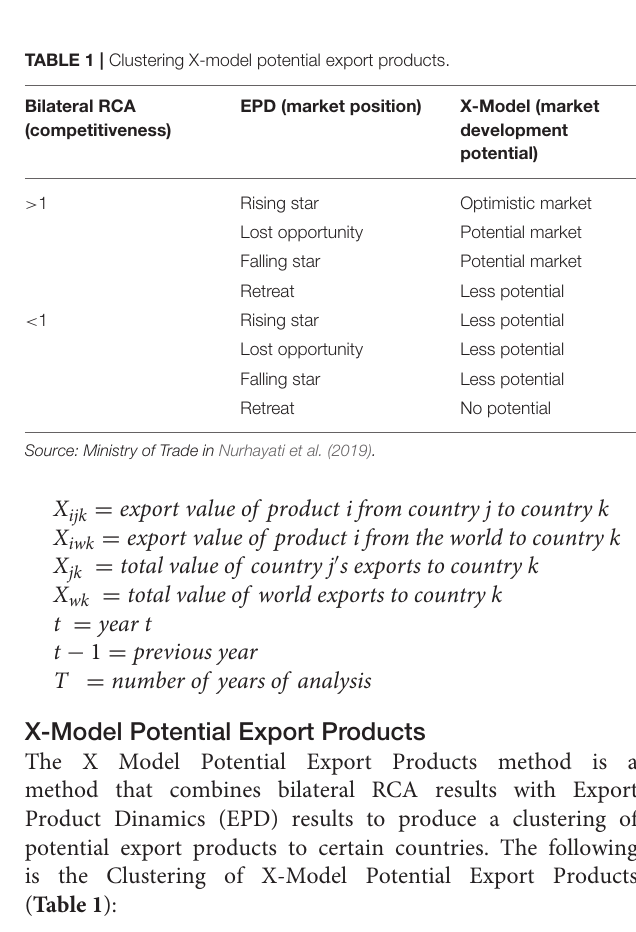
FIGURE 1 | Method of analysis policy formulation to support the competitiveness of Indonesian cocoa in the global market.